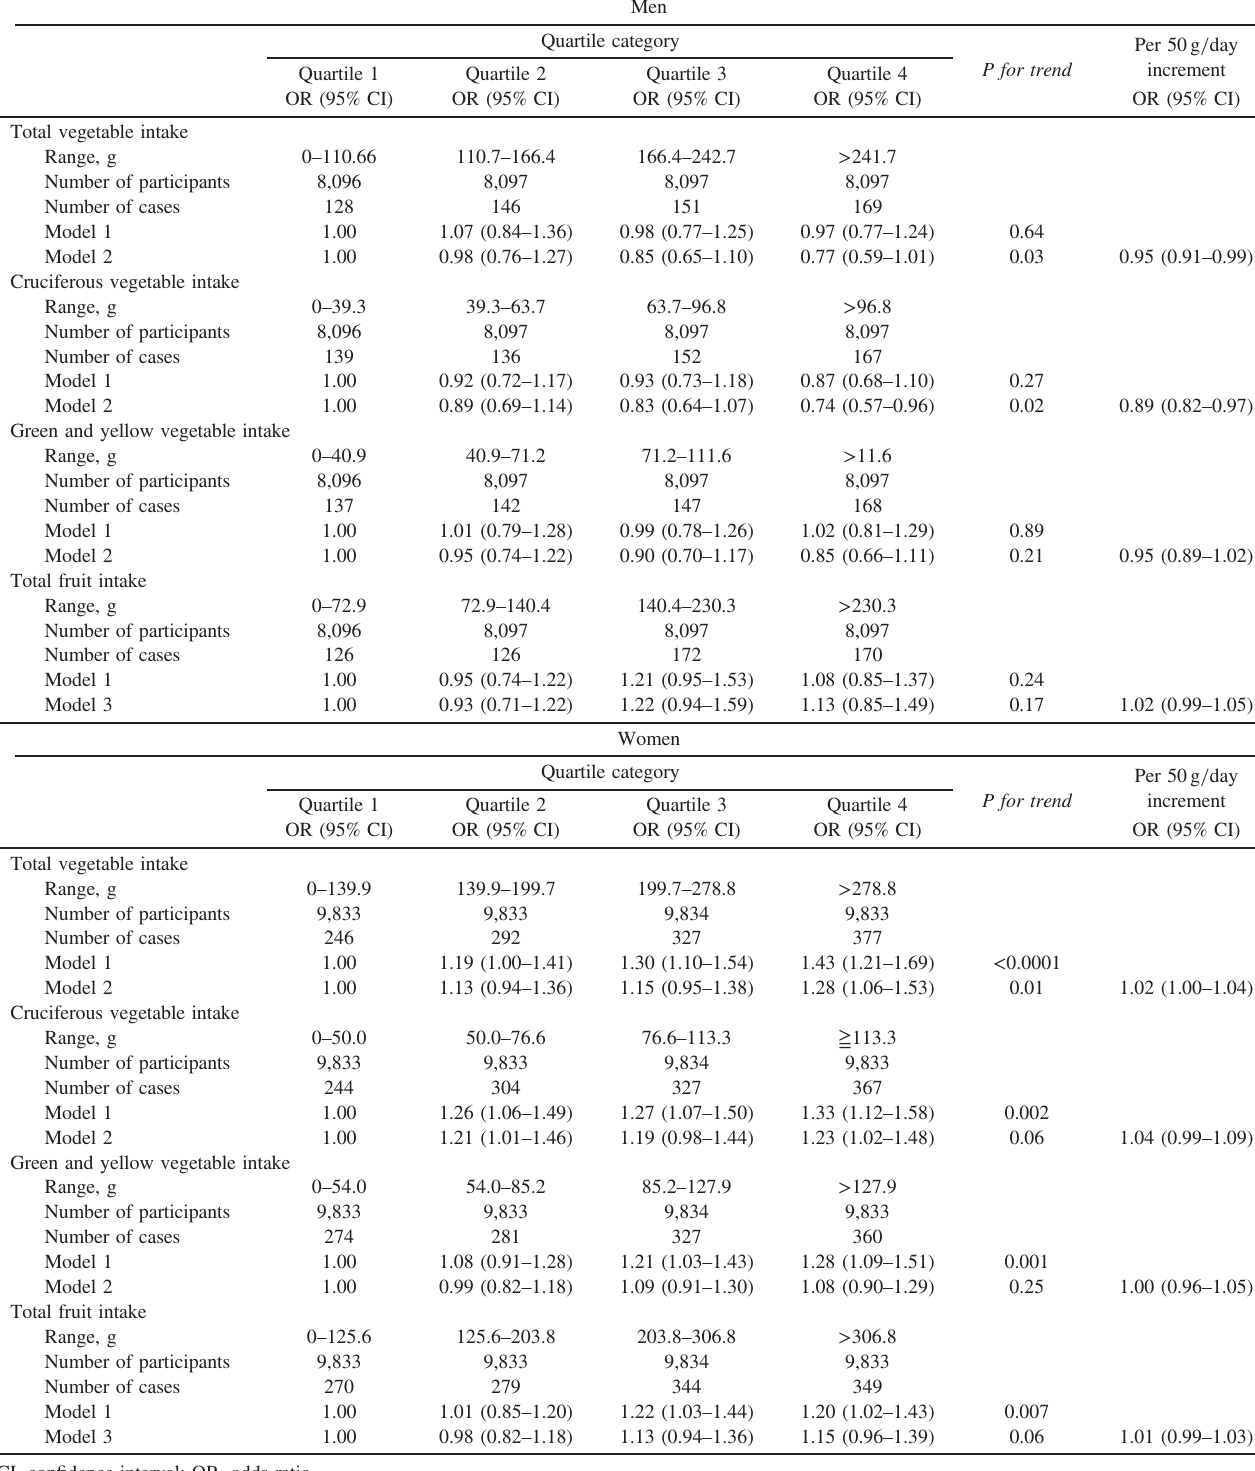
Table 2. Age- and area-adjusted odds ratios and multivariate odds ratios for cataract incidence according to total vegetable, cruciferous vegetable, green and yellow vegetable and fruit intake category in men and